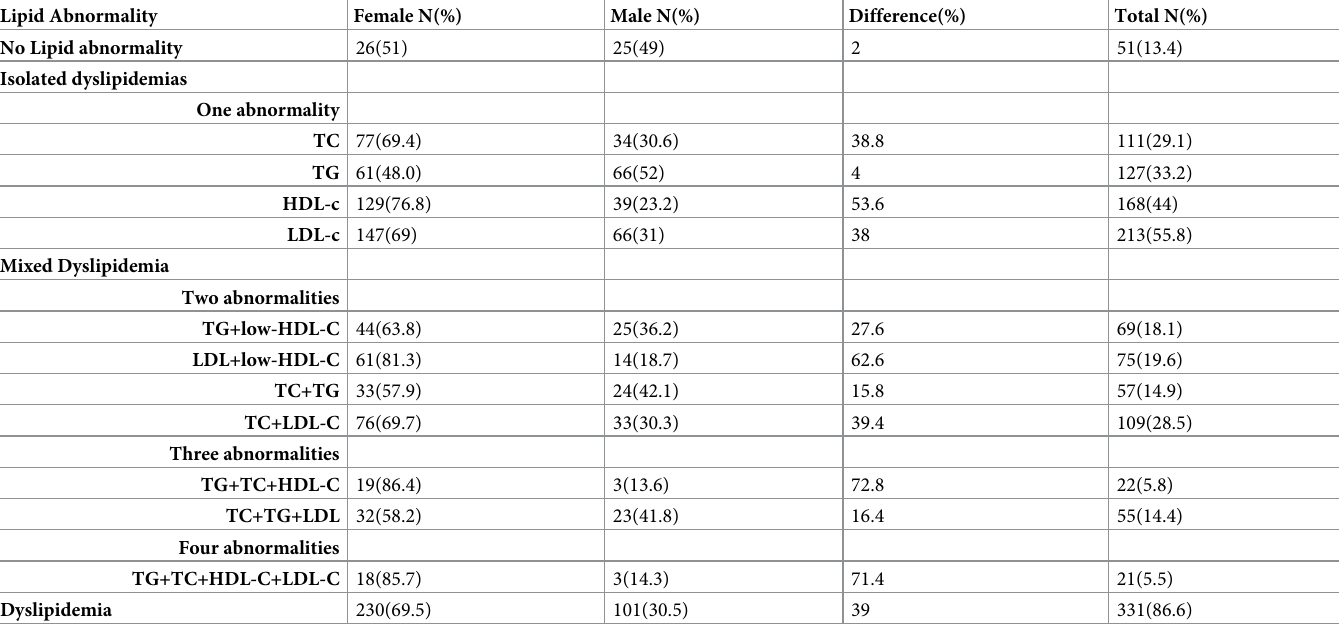
Table 2. Frequency of dyslipidemia and isolated and mixed dyslipidemia in HIV infected patients in Asmara, Eritrea. Lipid